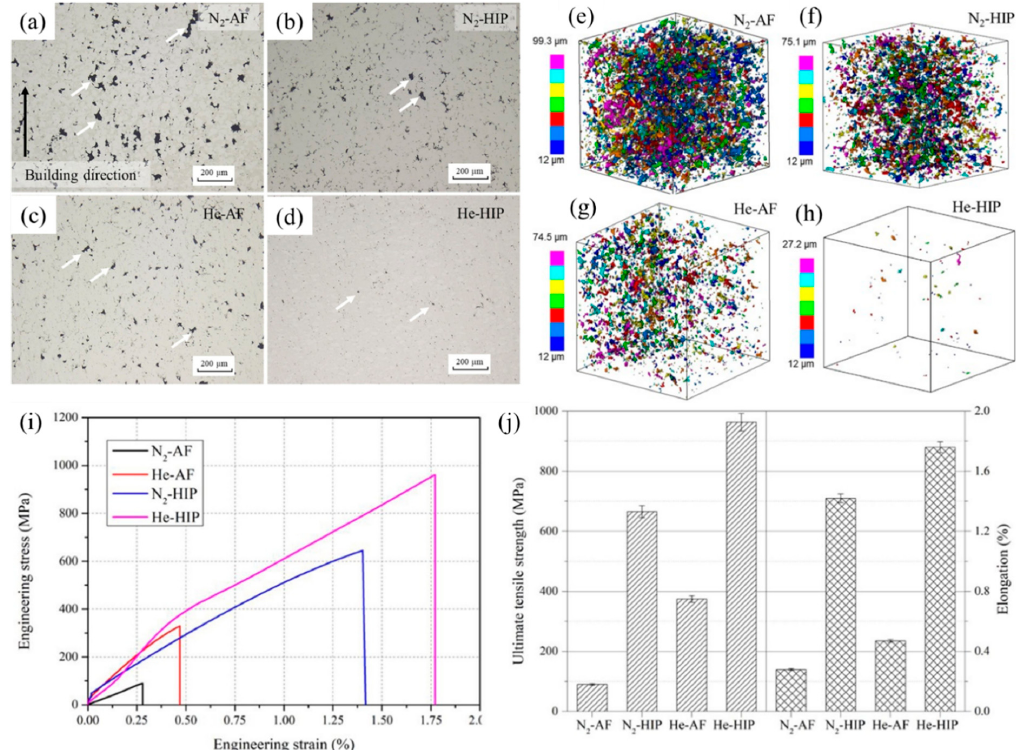
Figure 23. ( a – d ) Optical images of the cross-sections of cold sprayed Ti6Al4V samples treated under different conditions: ( a ) as-cold sprayed by using N 2 and ( b ) after HIP; ( c ) as-cold sprayed by using He and ( d ) after HIP; ( e – h ) 3D-reconstructions of the pores within the cold sprayed Ti6Al4V samples treated under different conditions: ( e ) N 2 -AF; ( f ) N 2 -HIP; ( g ) He-AF; and ( h ) He-HIP; ( i ) tensile stress-strain relationships and ( j ) ultimate tensile strengths of cold sprayed Ti6Al4V samples treated under the respective conditions (adapted from reference [95], with permission from ©